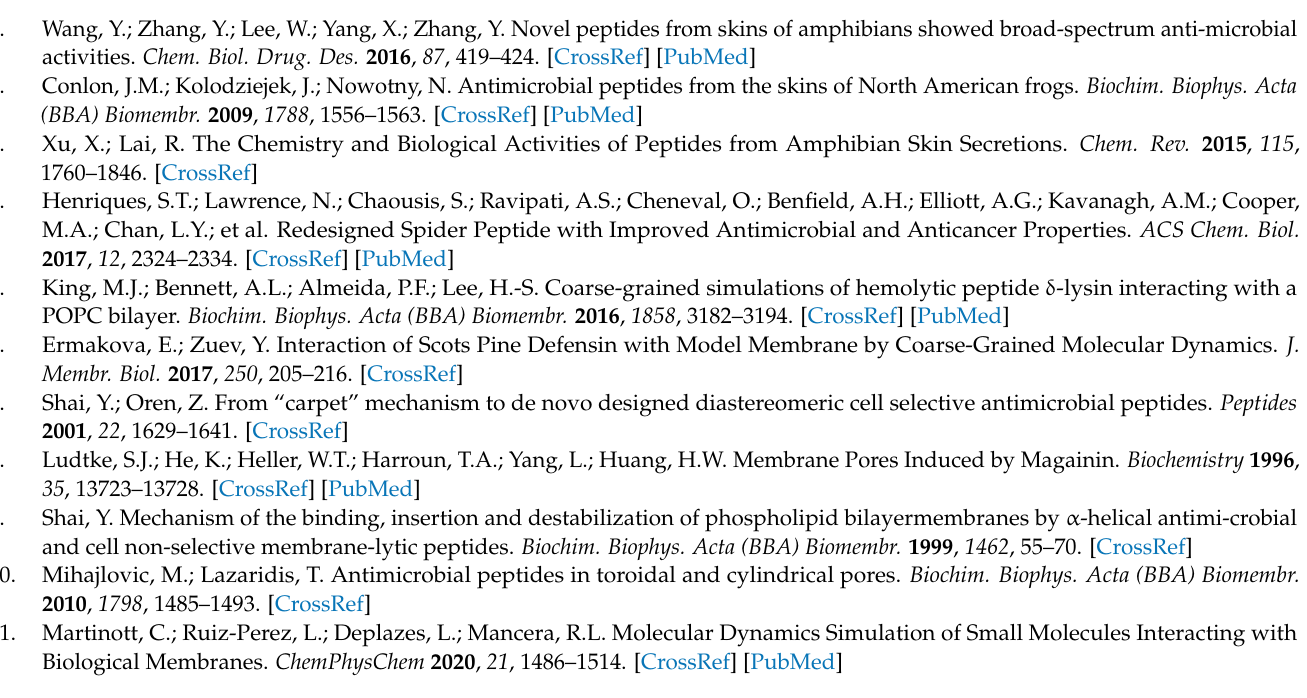
Figure S1: The time evolution of the angle (in ◦ ) between the main principal axis of uperin peptide and the normal to the membrane surface for the trajectory